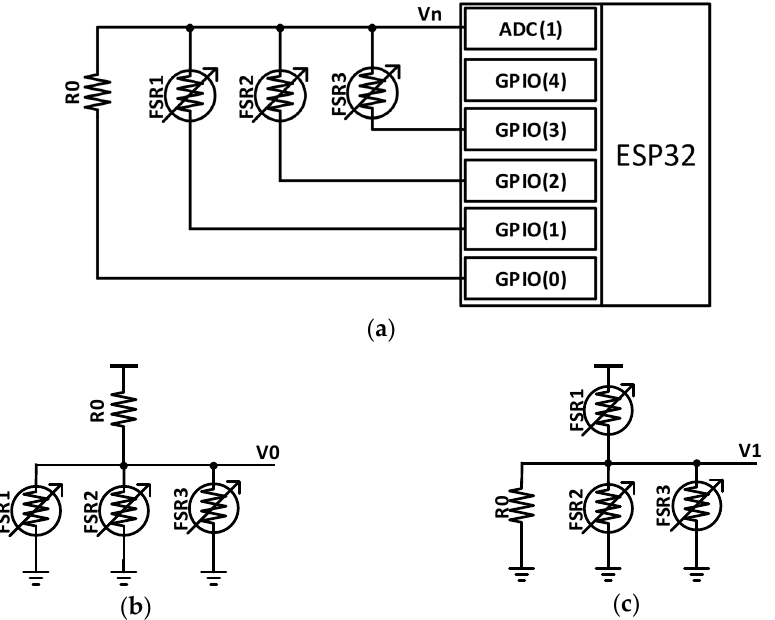
Figure 2. Proposed circuit design: ( a ) Entire design with the connection of 3 FSRs and R0 to the GPIO pins; ( b ) GPIO configuration to get the value of V0; ( c ) GPIO configuration to get the value of V1.